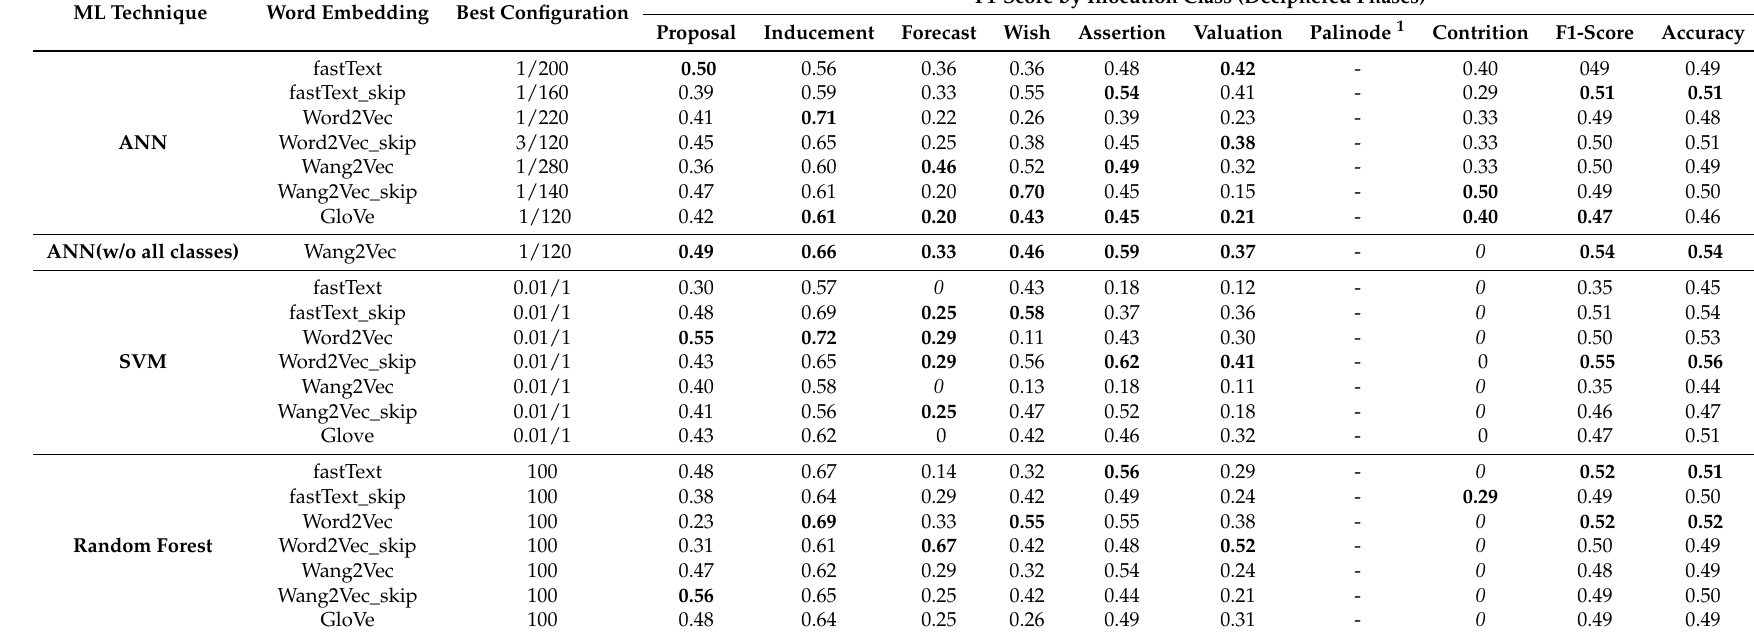
Table 5. Experimental results obtained with the ANN, SVM, and Random Forest classifiers with Deciphered Phases. Word embedding vector dimension: 600. Dataset divided into two sets of 80% and 20% for training and testing, respectively. The Weighted average F1-score column was calculated as a function of the number of tweets by each